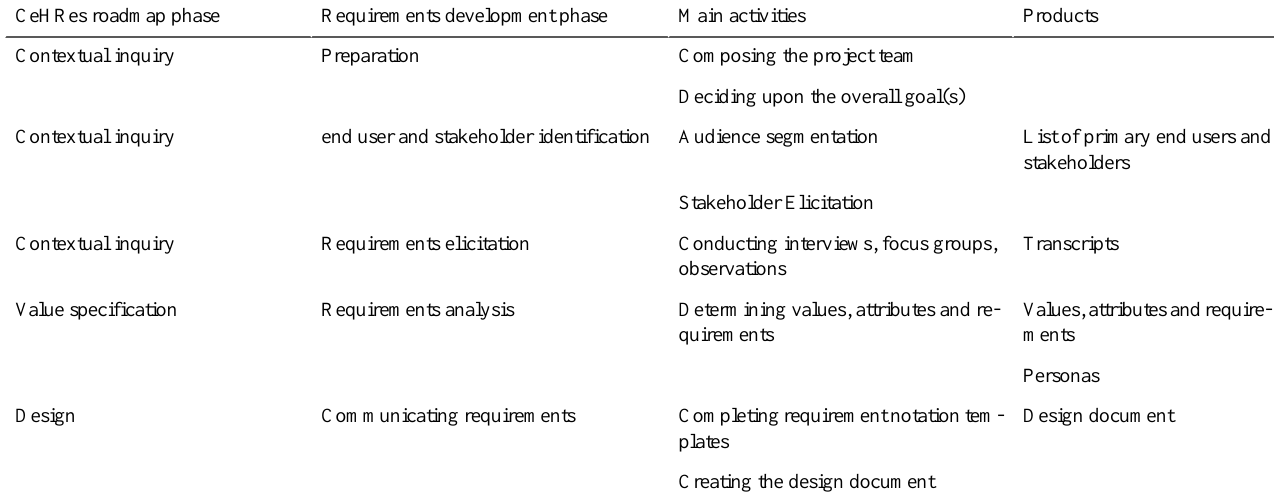
Table 1. Phases and main activities in the requirements development